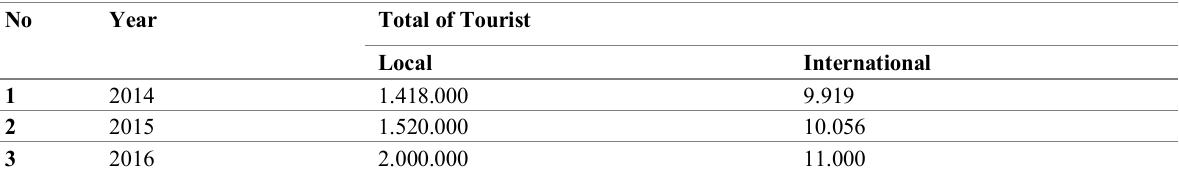
Table 1: Tourist visits in Jambi province